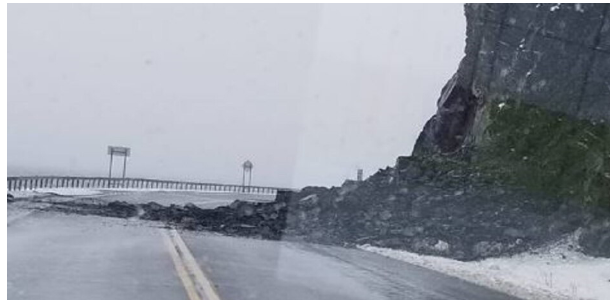
Figure 11. Rockfall that occurred on 16 April 2019, obstructing Route 132. © Philippe Langlais, TVA